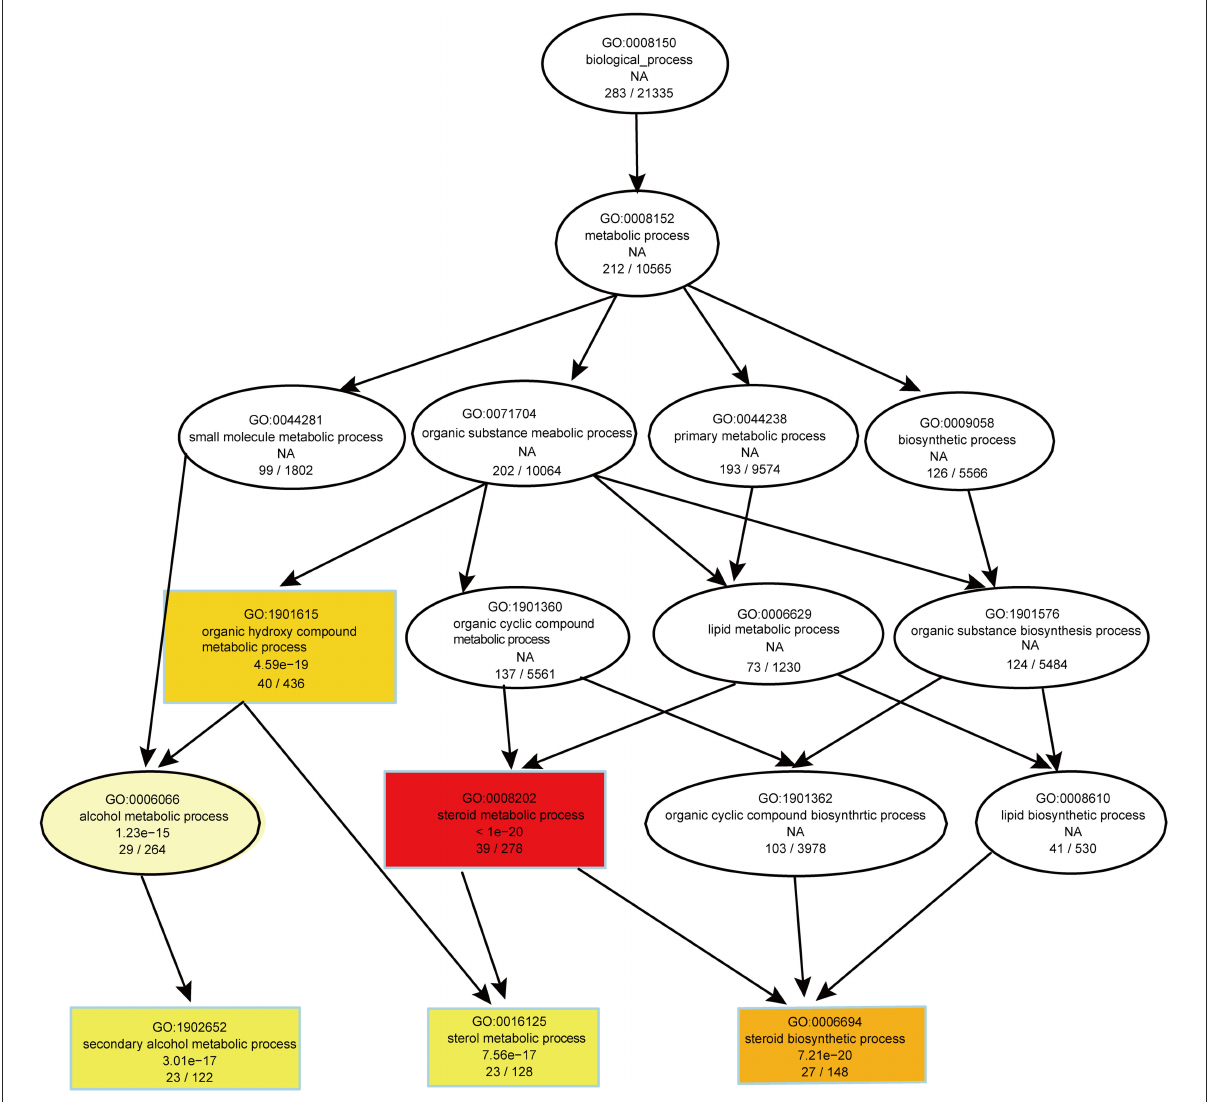
FIGURE4 Directed acyclic graph of GO term enrichment analysis for significantly upregulated DEGs in liver of 2% phytosterol-feeding